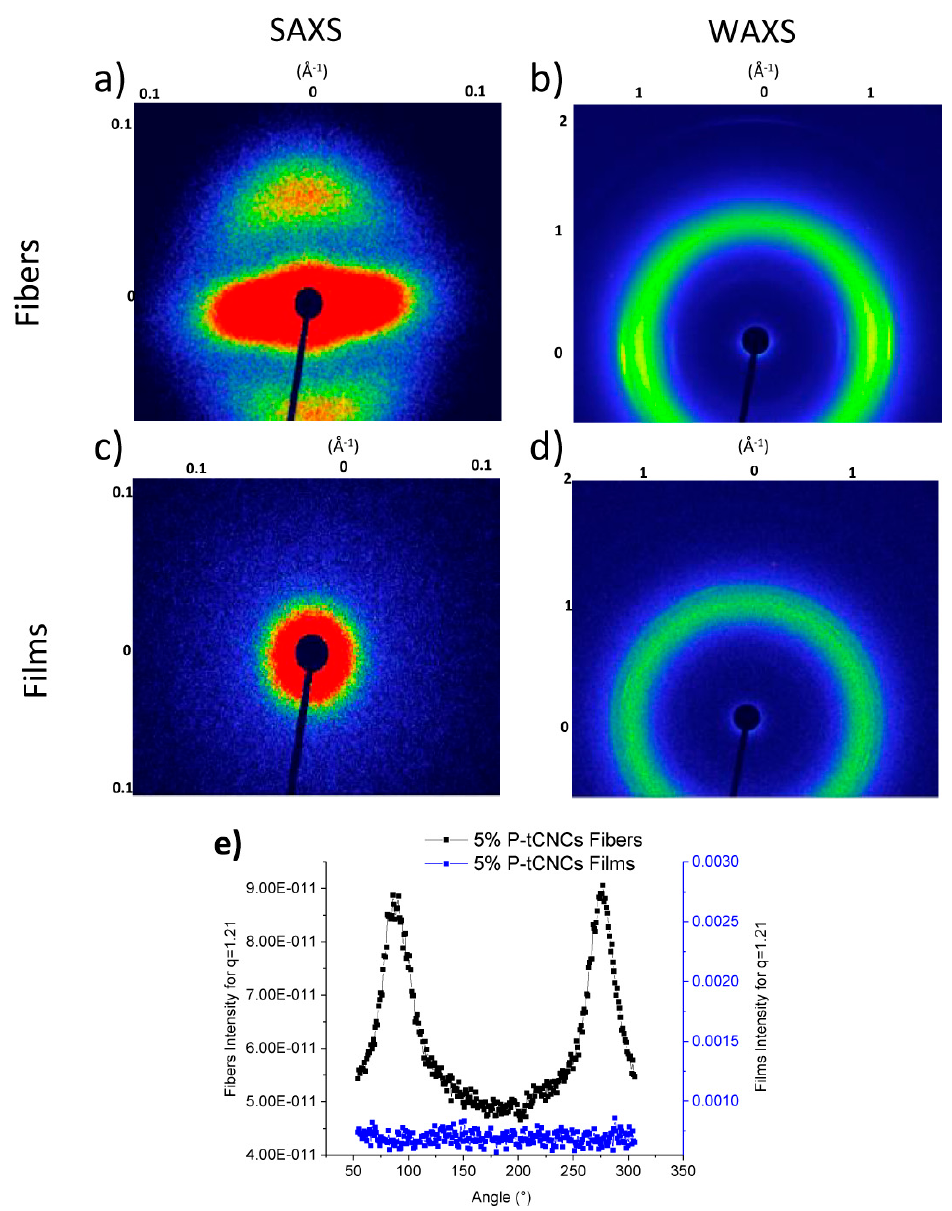
Figure 8. 2D small and wide-angle X-ray scattering spectra of ( a , b ) 5 wt% P-tCNC nanocomposite fibers and ( c,d ) 5 wt% P-tCNC nanocomposite films. ( e ) Azimuthal integration of the (200) P-tCNC reflection at q = 1.21 Å − 1 .